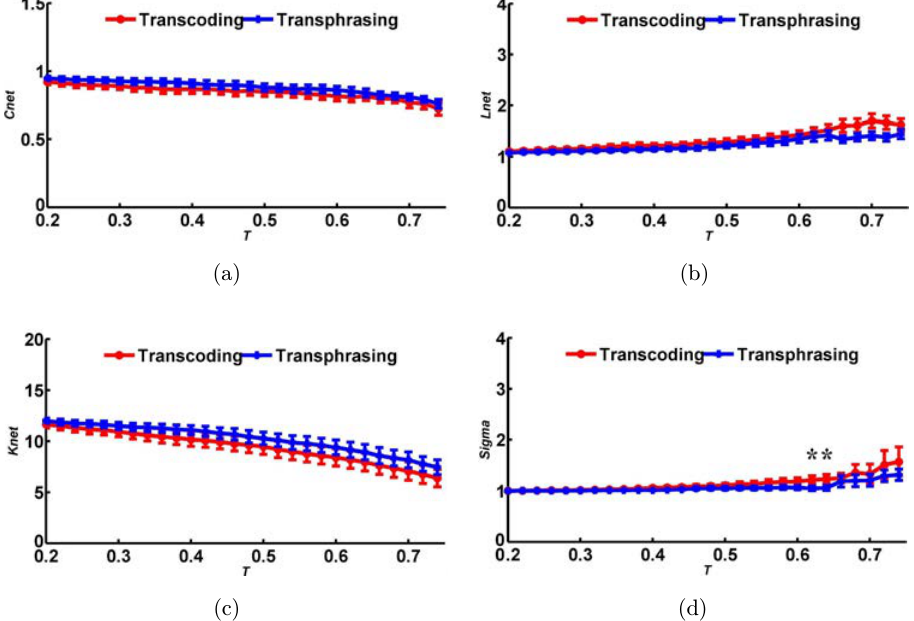
Fig. 5. Comparison of the small-world indicators between the transphrasing and transcoding translation strategy with absolute thresholding: (a) the clustering coe±cient, (b) average path length, (c) average node degree and (d) measure of small-worldness. The curves ð mean (cid:3) SE Þ show the network indicators with di®erent thresholds, in which the red and blue color represent the transcoding and transphrasing strategy respectively. The horizontal axes denote the threshold values whereas the vertical axes denote the network property indexes. * p < 0 :